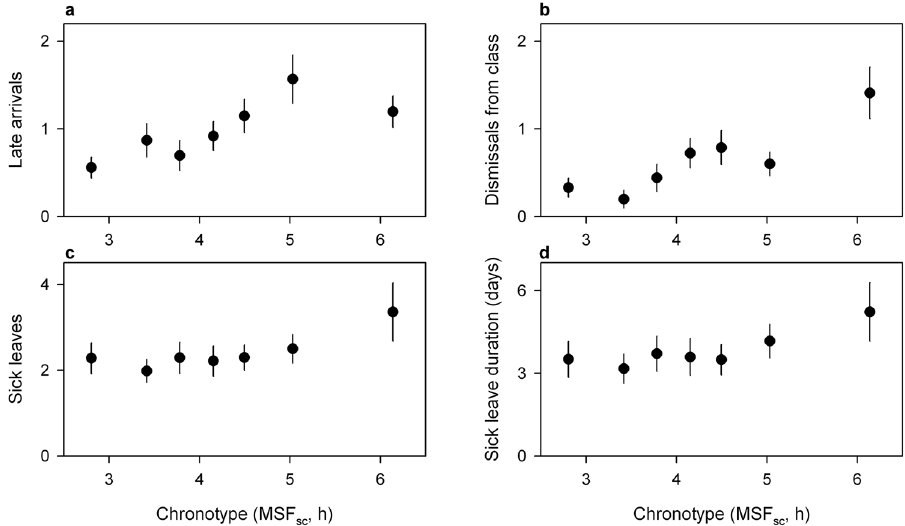
Figure 2. Influence of chronotype (MSF sc ) on school attendance. Data points represent mean number of late arrivals ( a ), dismissals from class ( b ), sick leaves ( c ) and days of sick leave ( d ) with standard error of the mean (SEM). The averages were calculated over the entire school year. The students were divided into 7 equal-sized groups based on chronotype (lower numbers correspond to earlier chronotypes and higher numbers to later chronotypes, respectively). Late chronotypes were significantly more likely to arrive late, be dismissed from class, become sick, and miss more days due to